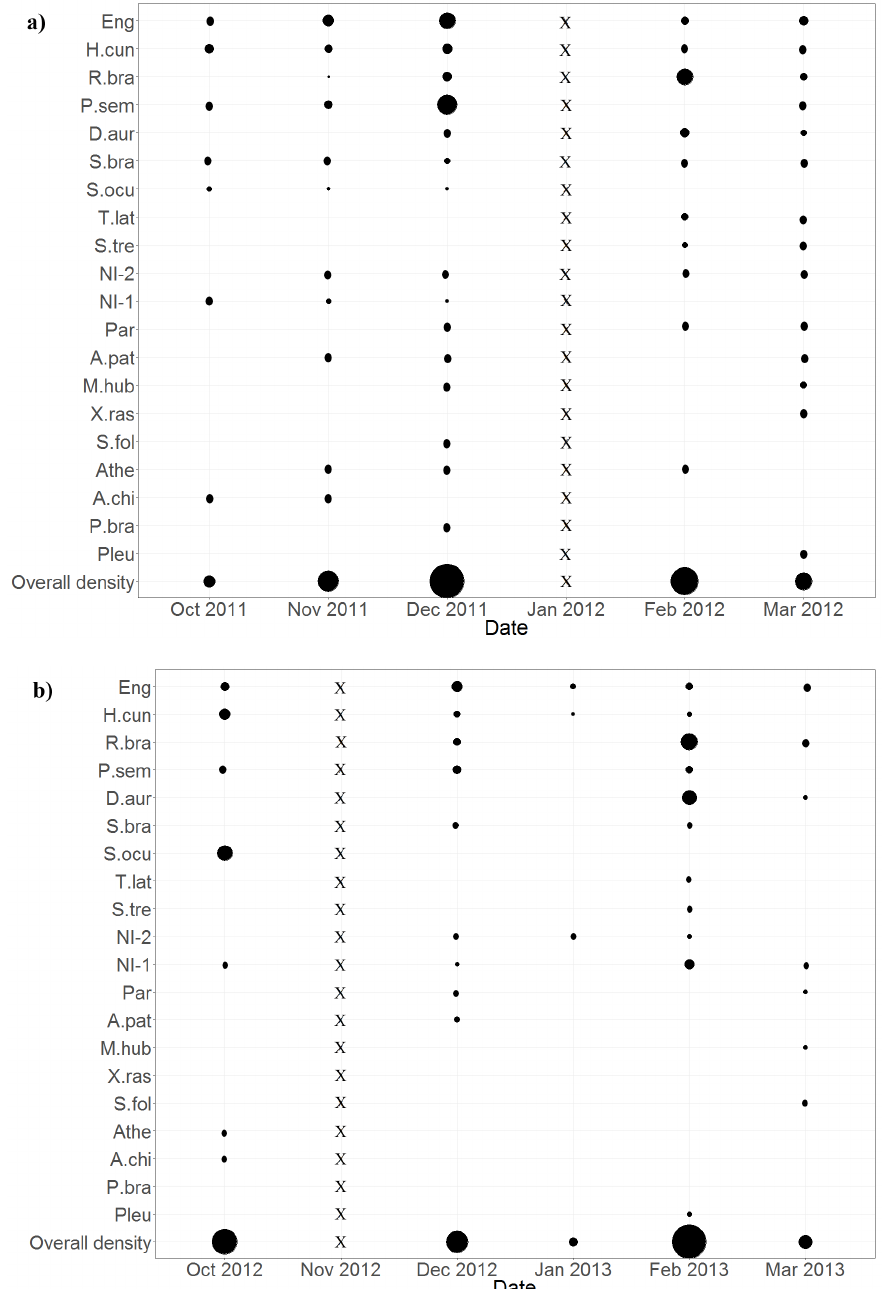
Figure 4. Bubble plots showing the mean monthly density of the larvae sampled within the San José Gulf during two consecutive years: a) Year 1: October 2011 to March 2012, and b) Year 2: October 2012 to March 2013. The diameter of the dots is proportional to larval density (number of larvae·100 m -3 ). The ranges for larval density were 0.01 larvae·100 m -3 – 268.36 larvae·100 m -3 , and 0.03 larvae·100 m -3 – 21.91 larvae·100 m -3 for Year 1 and 2, respectively. A.pat: Acanthistius patachonicus , A.chi: Agonopsis chiloensis , Athe: Atherinopsidae, D.aur: Dules auriga , Eng: Engraulidae, H.cun: Helcogrammoides cunninghami , M.hub: Merluccius hubbsi , Par: Paralichthys spp., P.bra: Percophis brasiliensis , Pleu: Pleuronectiformes, P.sem: Pseudopercis semifasciata , R.bra: Raneya brasiliensis , S.ocu: Sebastes oculatus , S.bra: Stromateus brasiliensis , S.tre: Symphurus trewavasae , S.fol: Syngnathus folletti , T.lat: Trachurus lathami , X.ras: Xystreurys rasile , NI: Unidentified species. X: Without